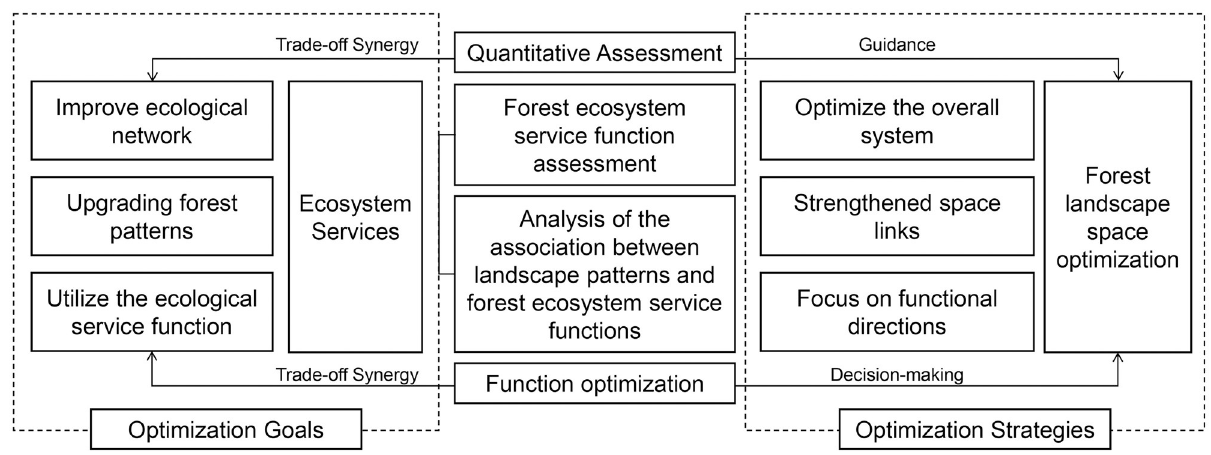
Fig 13. Relationships between forest ecosystem services and the spatial optimization of forest landscapes.